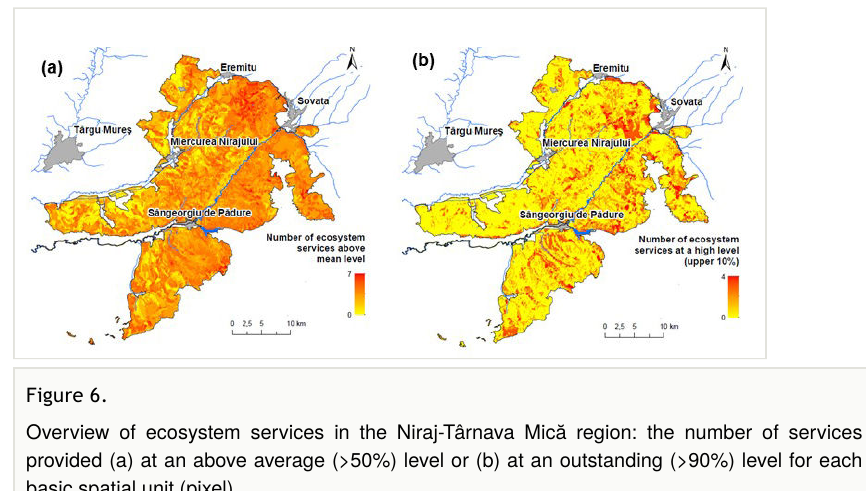
Overview of ecosystem services in the Niraj-Târnava Mic ă region: the number of services provided (a) at an above average (>50%) level or (b) at an outstanding (>90%) level for each basic spatial unit